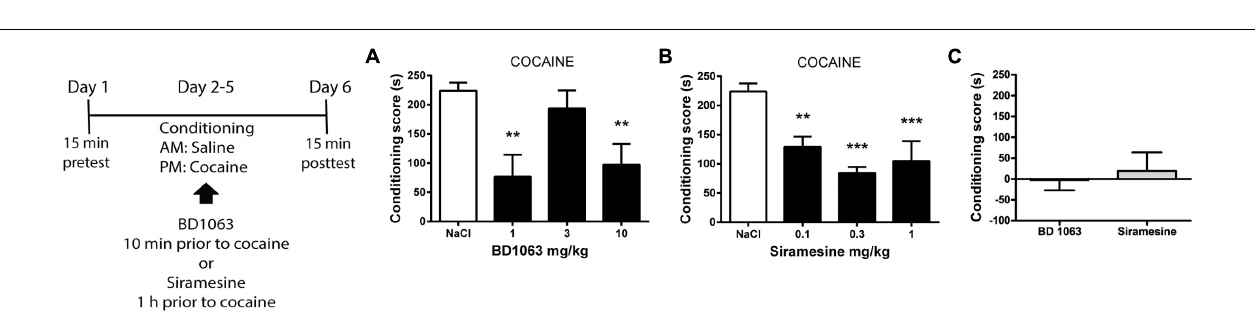
FIGURE 1 | Locomotor Measurements. Mean ± SEM of baseline locomotor measurements during exposure to (A) NaCl ( n = 24) vs BD 1063 [3 mg/kg ( n = 8) or 10 mg/kg ( n = 8)] and (B) NaCl ( n = 24) vs Siramesine [0.3 mg/kg ( n = 8) or 1 mg/kg ( n = 8)]. BD 1063 had no effect on baseline locomotor activity, whereas Siramesine significantly attenuated it at 5, 20, and 25 min. (C) BD 1063 mitigates acute cocaine-induced hyperlocomotion in the last half of the 30-min tracking interval. (D) Siramesine also attenuated the acute cocaine-induced increase in locomotor activity as designated by significance in the two-way ANOVA. Locomotor measurements from NaCl-treated control mice were pooled and represented in both graphs. # , ∗ p < 0.05, ∗∗ p < 0.01, ∗∗∗ p < 0.001. Two-way ANOVA followed by Bonferroni’s post hoc test.